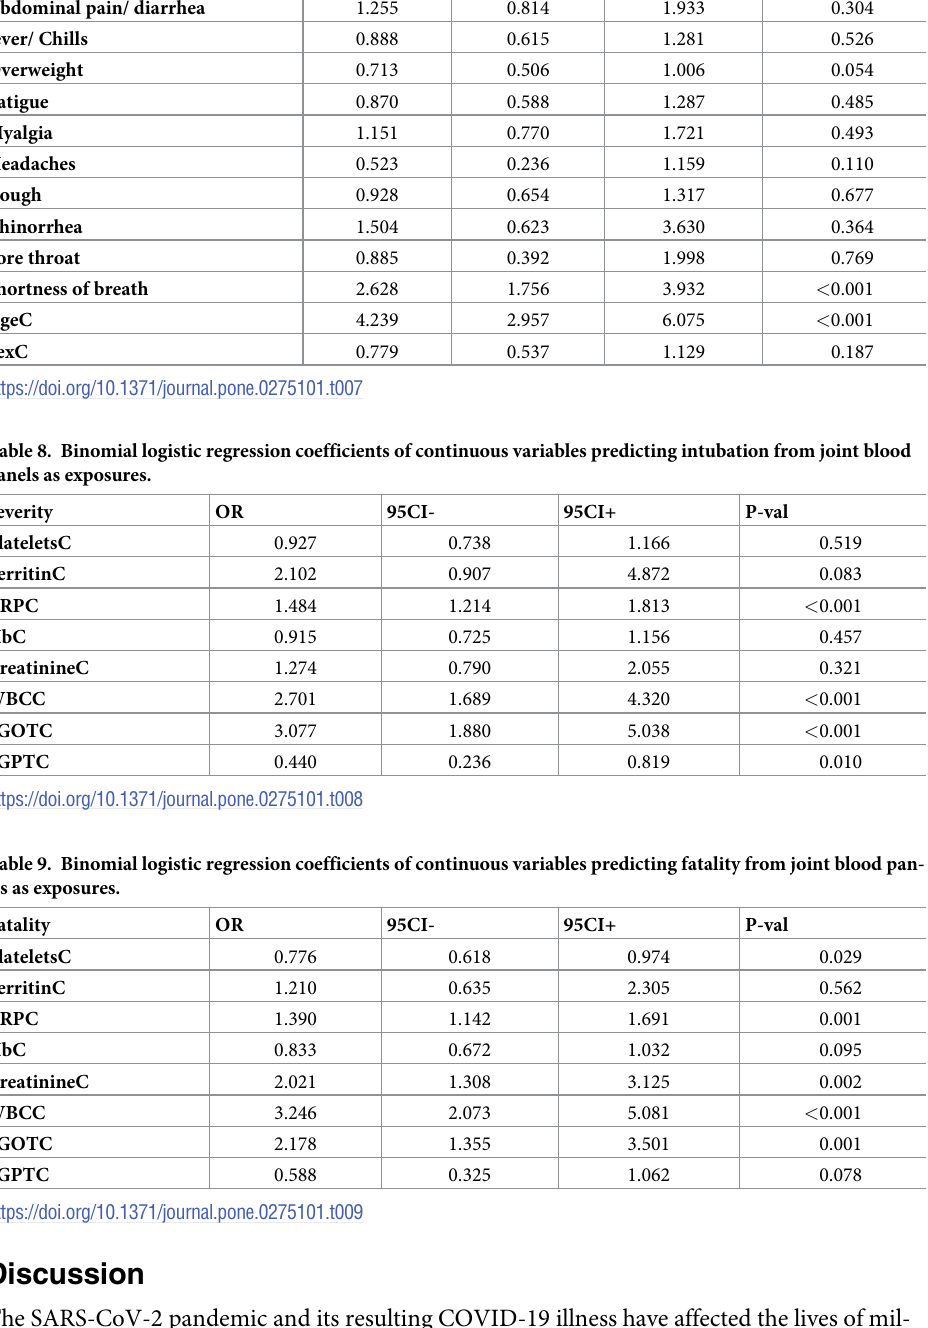
Table 7. Binomial logistic regression coefficients of various factors predicting fatality from joint symptoms as exposures. Fatality